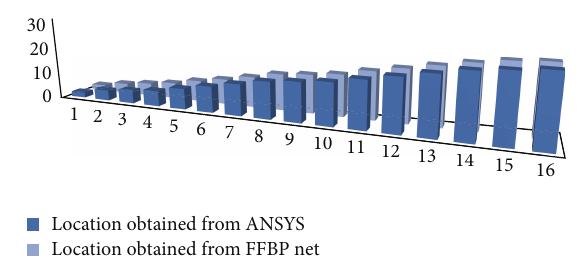
Figure 14: Comparison of result of crack location between ANSYS and FFBP network.